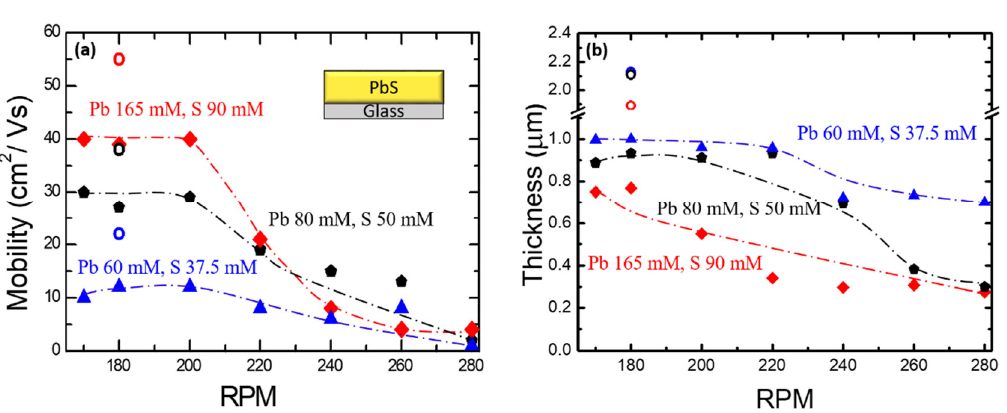
Figure 1. ( a ) Mobility and ( b ) thickness of PbS films as a function of RPM for various Pb and S concentrations. PbS film thicknesses were measured from cross-sectional SEM images. Both mobility and film thickness are seen to decrease as RPM increases. The dashed curves are for guiding eyes. Open circles (